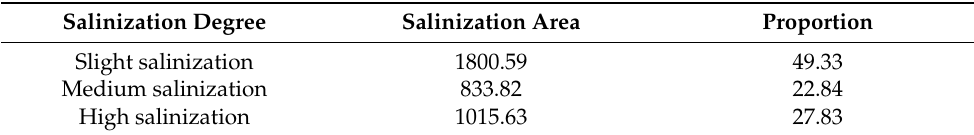
Table 2. Proportion of the salinization area in the shallow basket lake wetland.